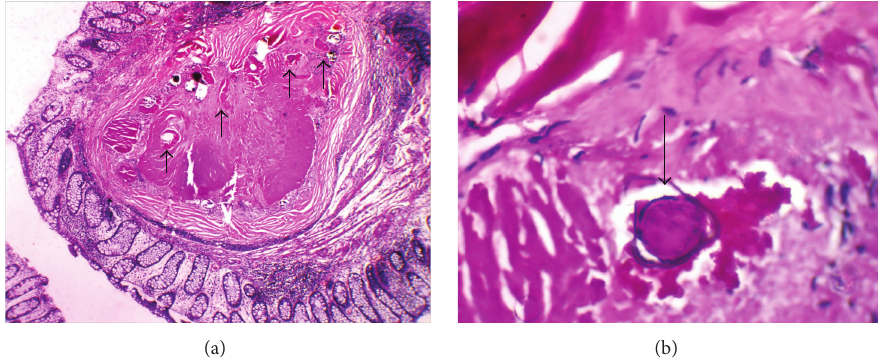
Figure 3: (a) Histological aspect—confluent granulomas with fibrosis, containing calcified S. mansoni eggs (black arrows) (HE 100x). (b) Histological aspect—detailed view of a S. mansoni partially calcified egg surrounded by hyaline fibrosis (black arrow) (HE